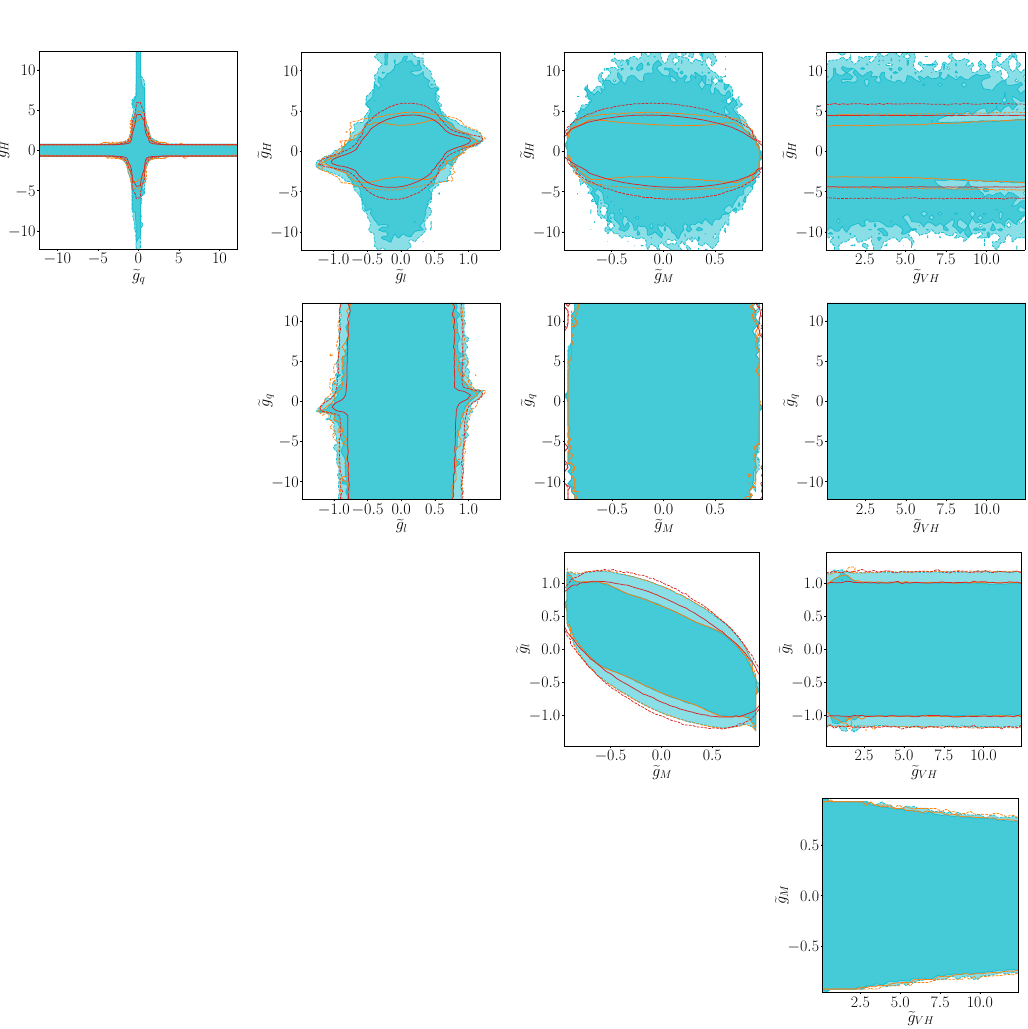
. The light blue V . V and ˜ g within the physical M VH